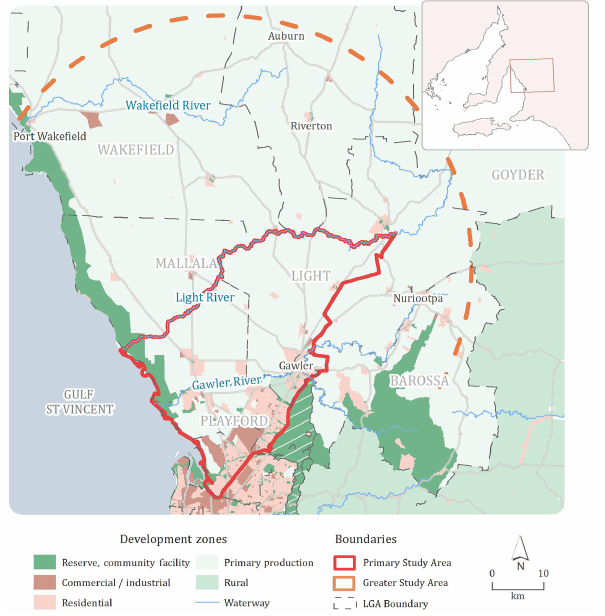
Figure 2. Proposed development region in Northern Adelaide Plains, South